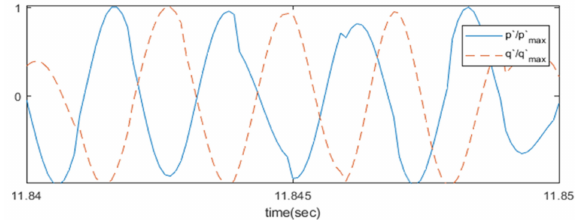
Figure 13. Overlay of normalized p (cid:48) and q (cid:48) in test